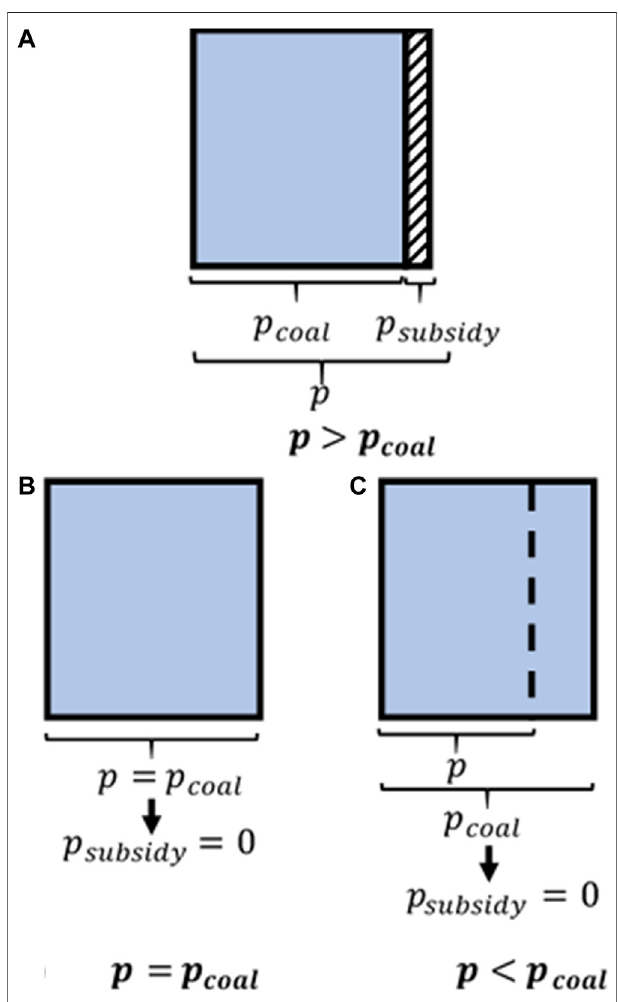
FIGURE 6 | Relationship among the declared electricity price of centralized PV projects ( p ) , the coal- fi red power price ( p coal ) , and state subsidies ( p subsidy )